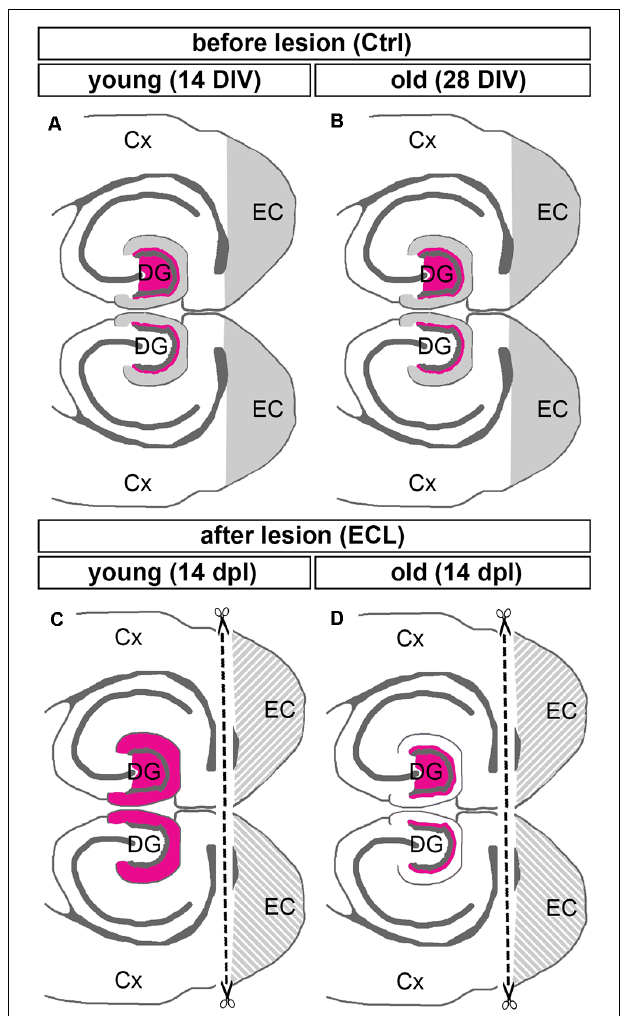
FIGURE 4 | Summary diagram illustrating maturation-dependent differences in the sprouting of commissural/associational mossy cell axons after entorhinal lesion. (A,B) Before lesion (control, Ctrl) DIV 14 (young) and DIV 28 (old) double entorhino-hippocampal tissue cultures showed an organotypic and layer-specific entorhinal innervation of the outer molecular layer of the dentate gyrus (DG, gray). Commissural/associational axons arising from hilar mossy cells terminate in the inner molecular layer of the dentate gyrus (magenta; only the mossy cell projection of the upper DG is shown). (C,D) Fourteen days post-lesion (dpl) a robust sprouting response is seen in young cultures (C) . In these cultures, commissural/associational axons grow into the denervated zone up to the hippocampal fissure. This corresponds to the juvenile sprouting response reported for commissural/associational axons in vivo . (D) In contrast, in older cultures commissural/associational axons stayed largely in their home territory and did not invade the denervated zone. This corresponds to the adult pattern of sprouting of commissural/associational axons seen in vivo . Note, only the mossy cell projection of the upper DG is shown in (C,D) . Cx, cortex; EC, entorhinal